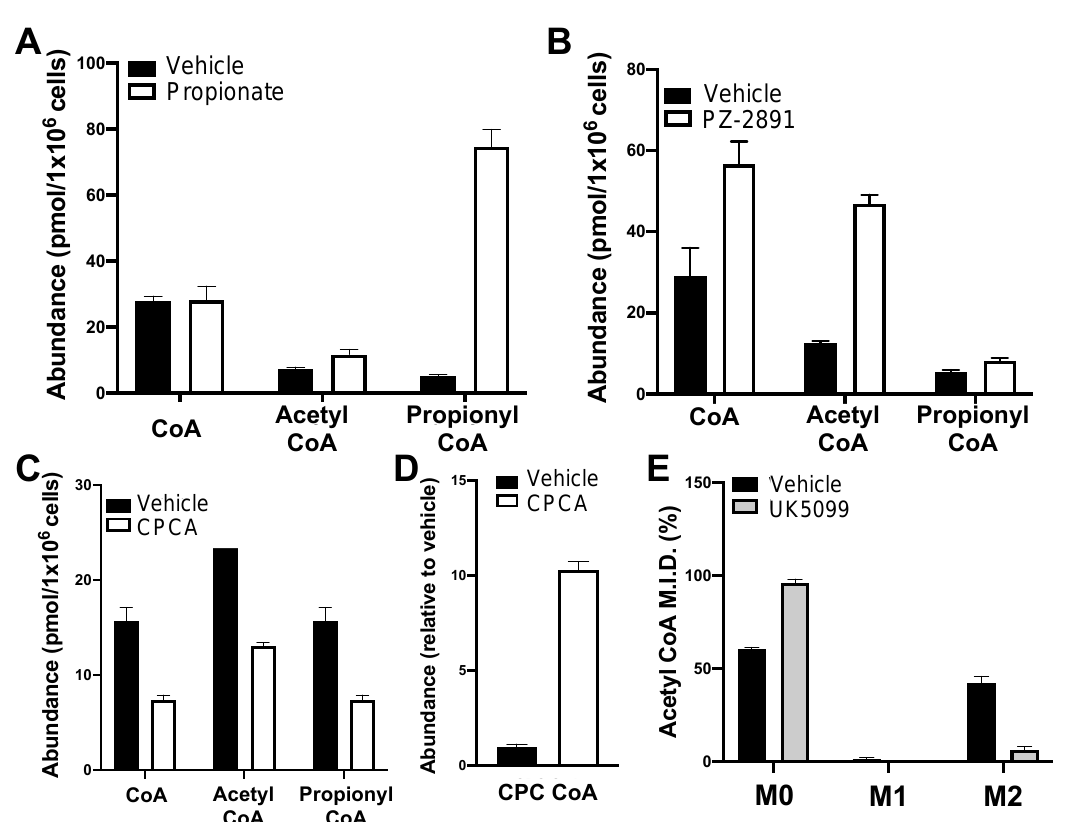
Figure 6. The sample preparation and method successfully detects expected perturbations in CoA metabolism: ( A – D ) HepG2 cells were treated for 24 h. with 1 mM propionate ( A ), 10 μM PZ-2891 ( B ), or 1 mM cyclopropanecarboxylic acid (CPCA; C , D ). CoA and short-chain acyl CoA esters were extracted and measured as described above. ( E ) Mass isotopologue distribution (M.I.D.) of acetyl CoA extracted from HepG2 cells treated for 24 h. with U- 13 C 6 -glucose. All data are presented as mean ± standard error of the mean (S.E.M.) for n = 3 technical